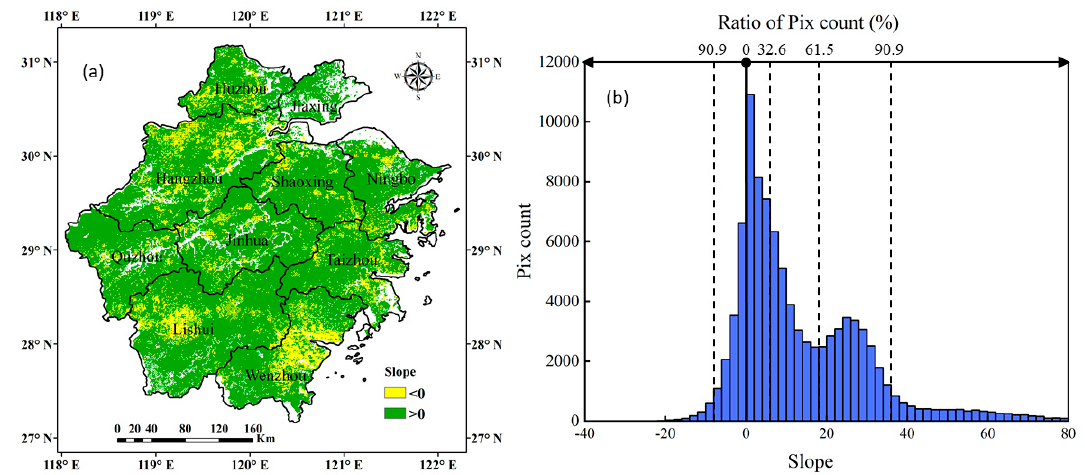
Figure 11. ( a ) NEP changes in various cities in Zhejiang Province and ( b ) histogram of the frequency distribution from 1985 to 2015.